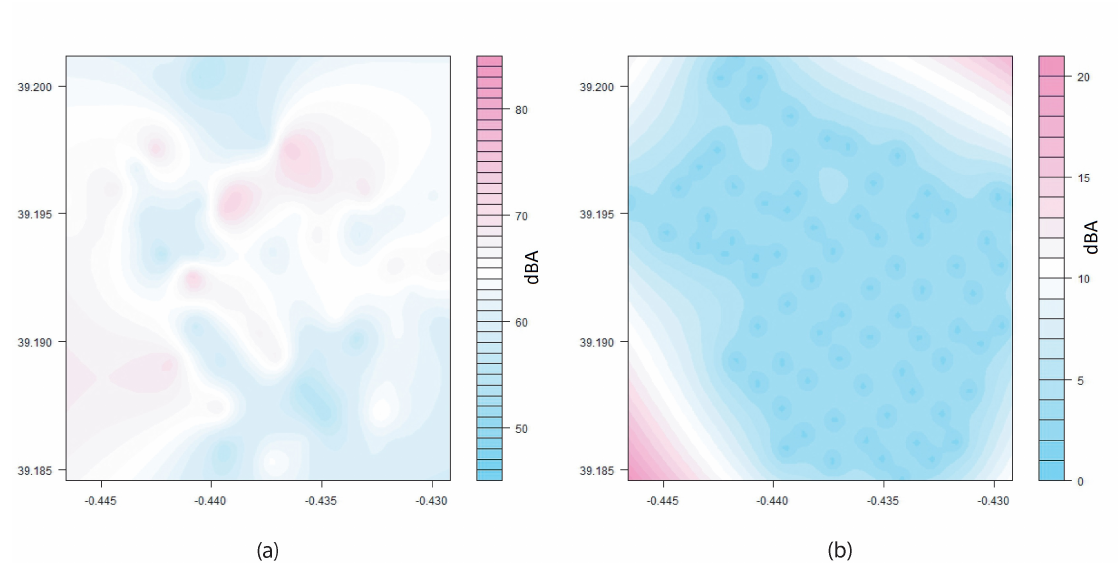
Figure 7. ( a ) average estimated noise level; and ( b ) average prediction